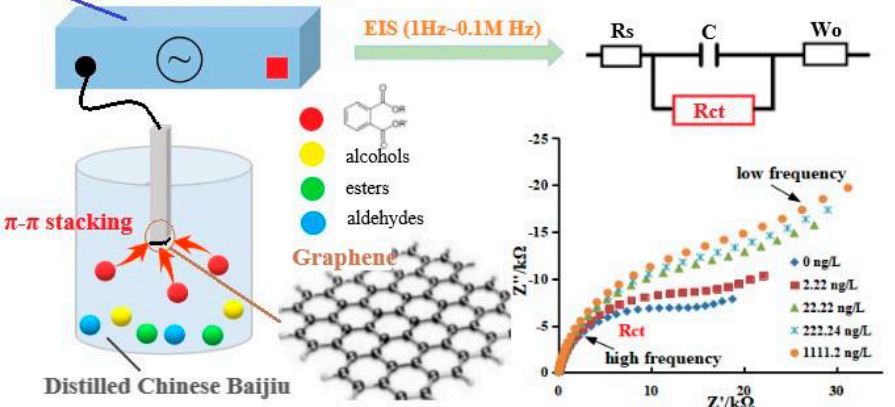
Figure 9. Basic strategy of electrochemical impedance detection of PAEs in liquor (reprinted from Ref. [38]).